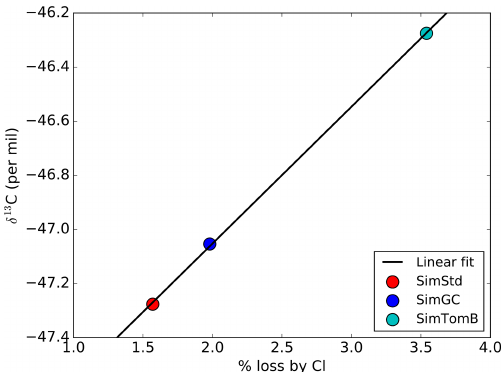
Figure 11. Area-weighted global mean surface δ 13 C for the SimStd (red), SimGC (blue), and SimTomB (cyan) simulations in 2004 as a function of the percent of CH 4 loss occurring by reaction with Cl. The linear best-fit line is shown in